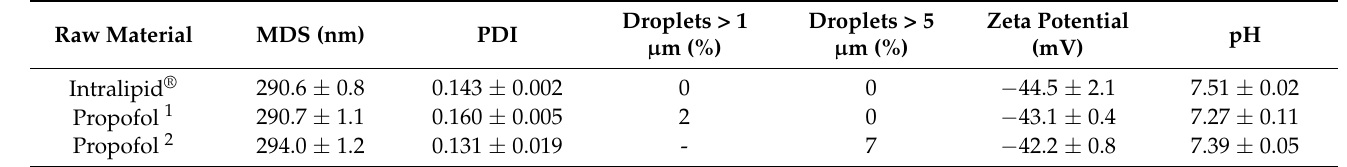
Table 3. Characteristics of extemporaneous addition of propofol in Intralipid ® 20%